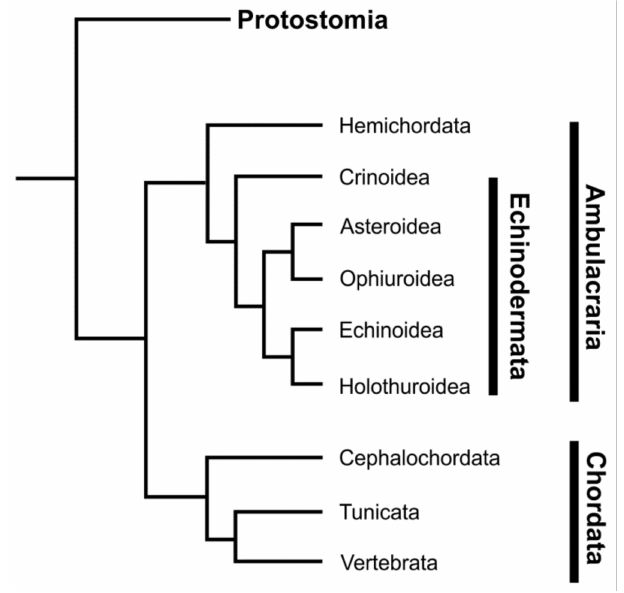
Figure 1. Phylogenetic tree showing the relationship of echinoderms to other animal